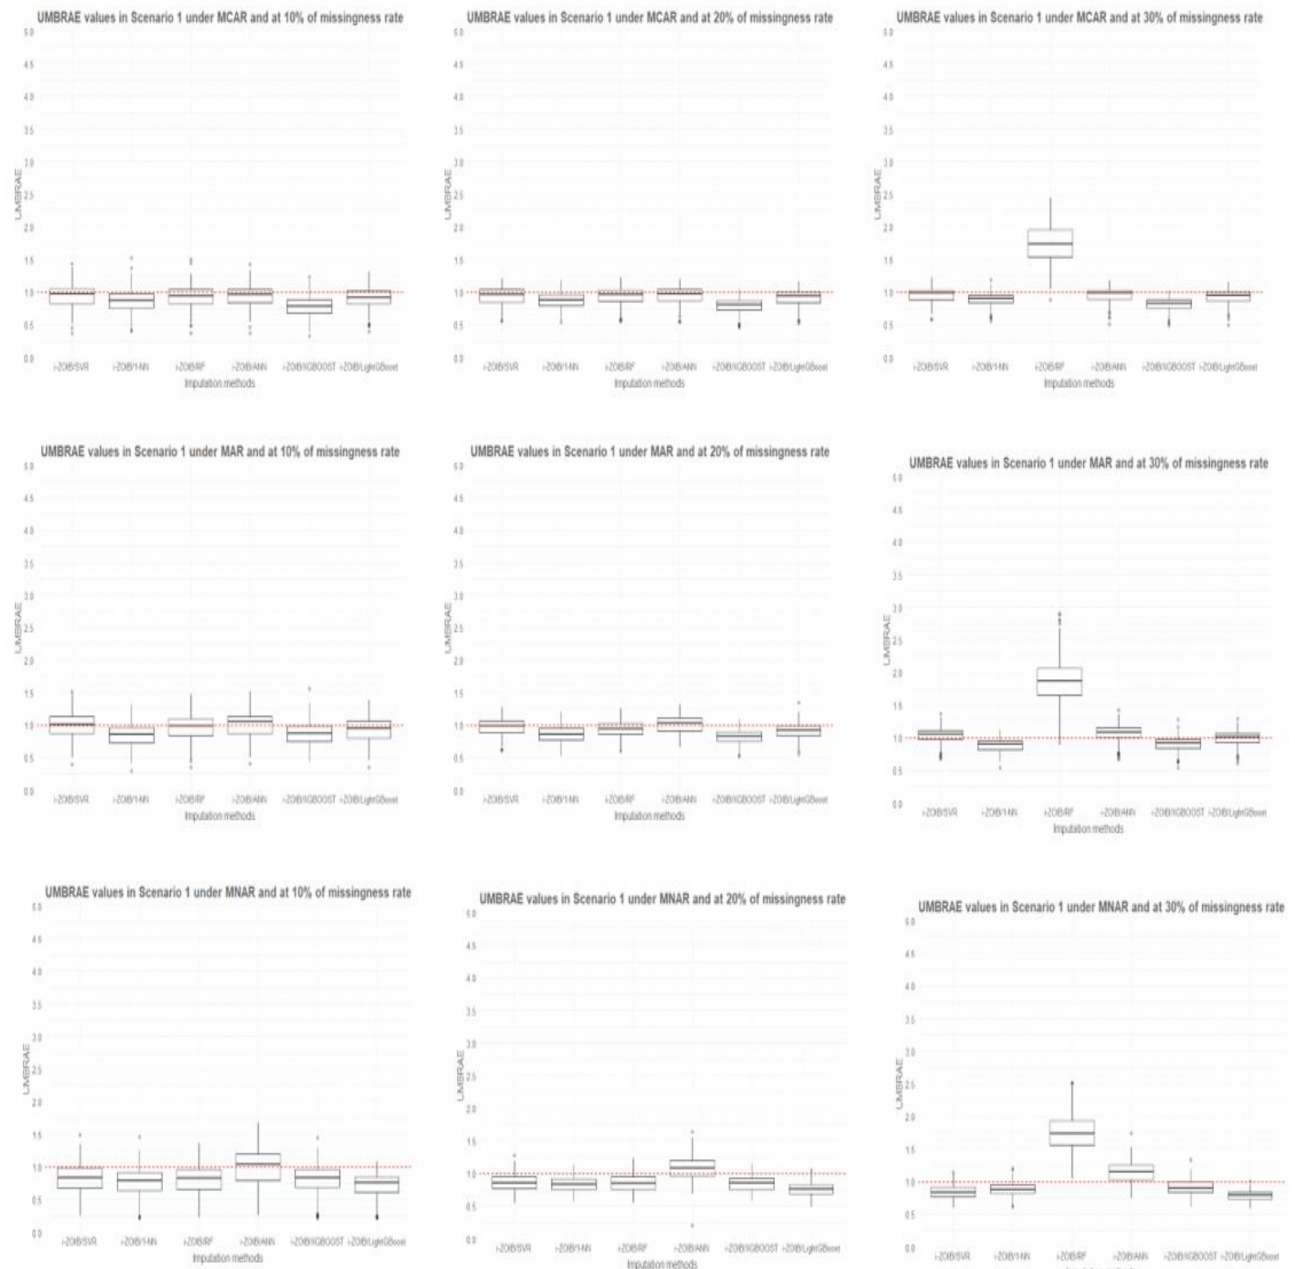
Figure 4. Boxplots of UMBRAE values according to the missingness mechanisms and rates in the Scenario